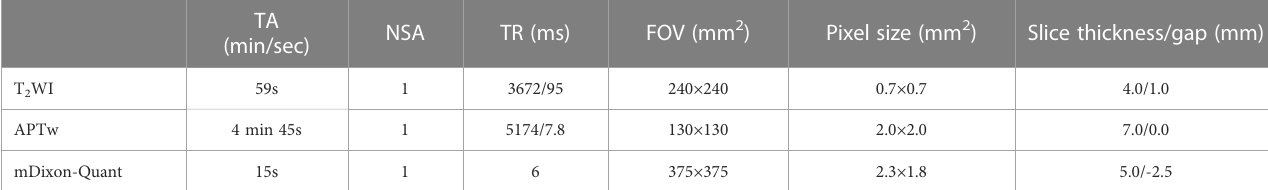
TABLE 2 T 2 WI, APTw, and mDixon-Quant scan parameters.